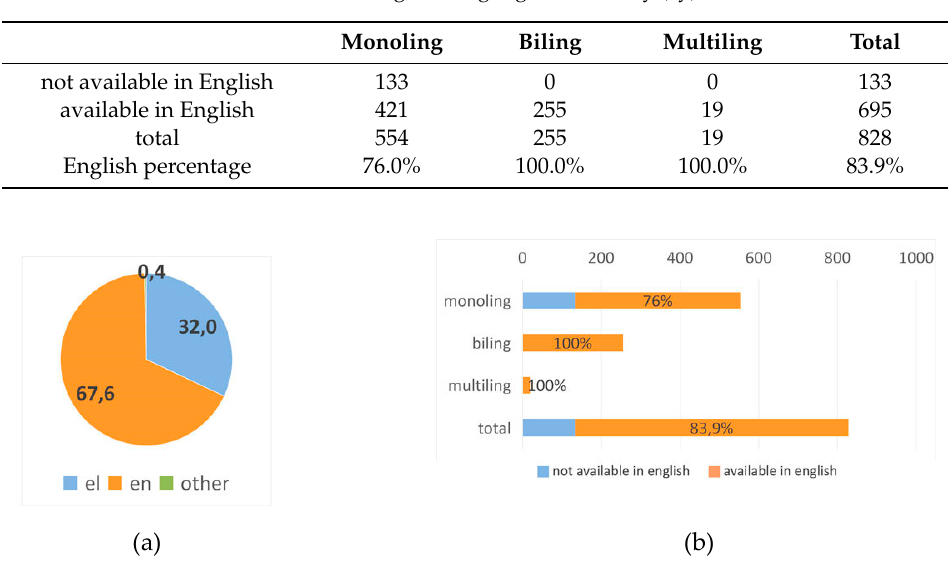
Figure A5. Visualization of the results for domain cy. ( a ) Primary languages pie chart and ( b ) English language availability bar chart.